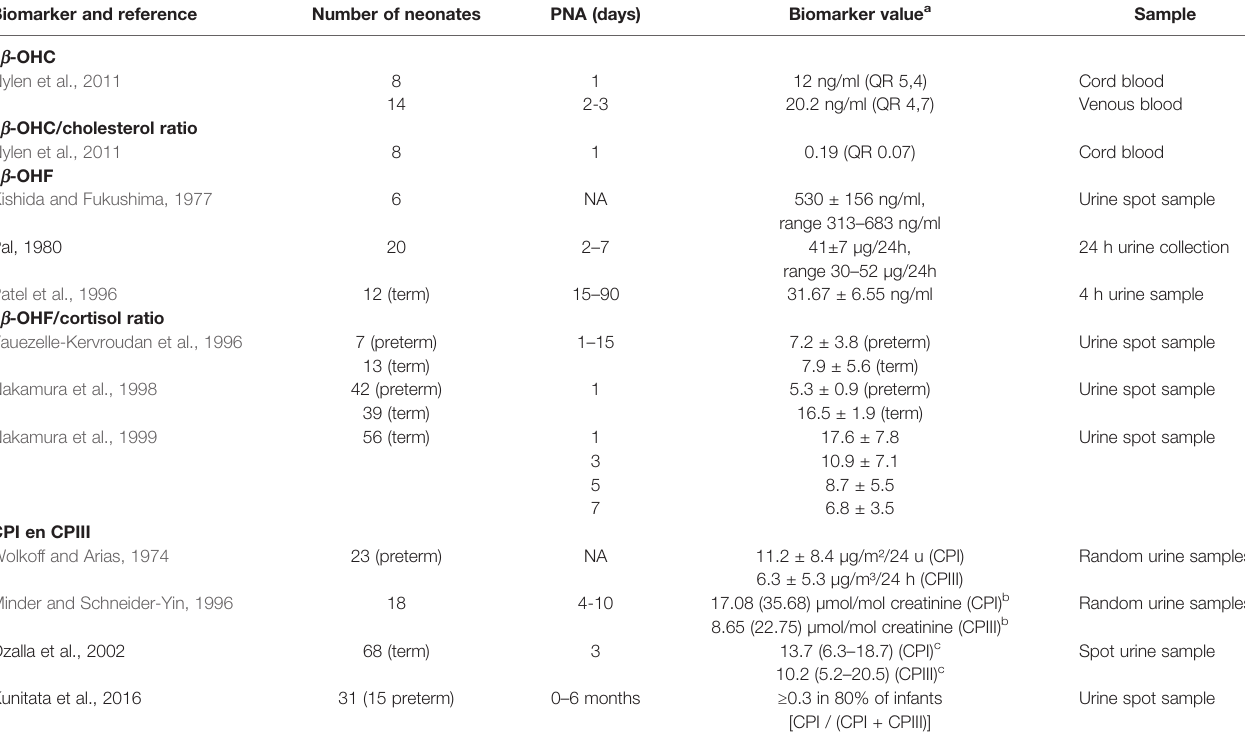
TABLE 2 | Summary of biomarker values (surrogates for CYP3A and OATP1B1/3 activity) of healthy (pre)term neonates as retrieved in English papers of which full text was accessible. Biomarker and